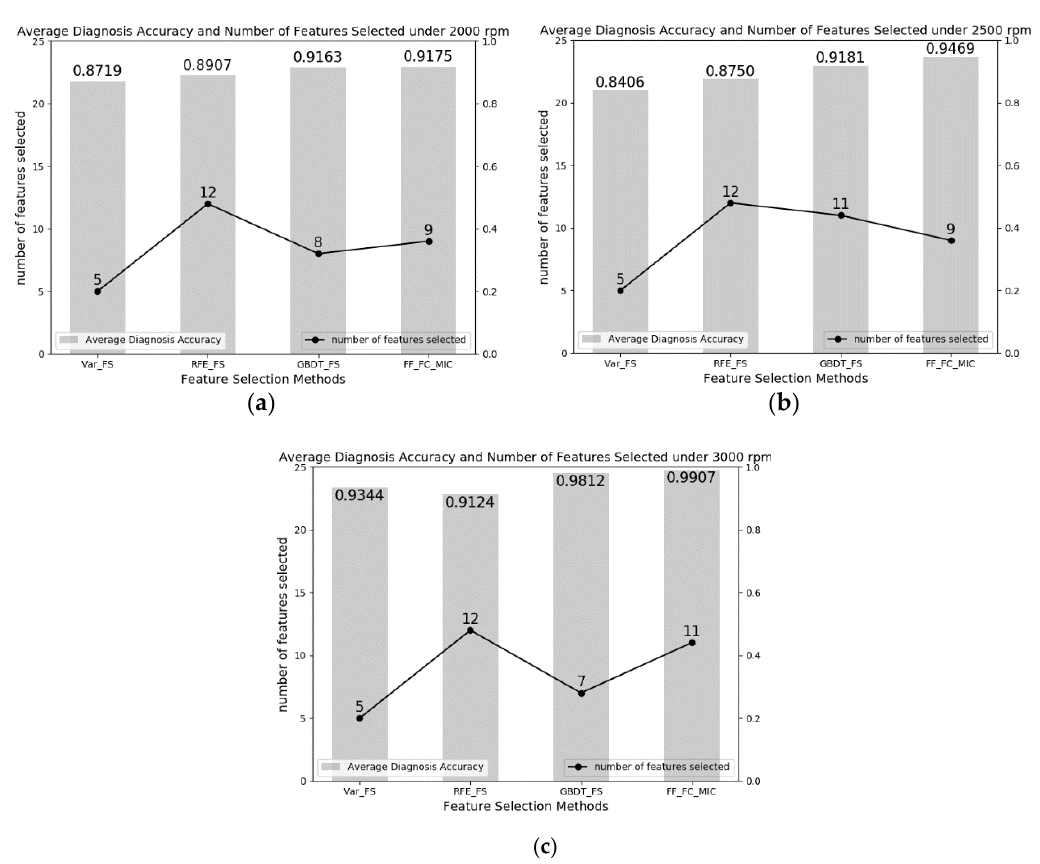
Figure 6. Average diagnosis accuracy of fault and number of features selected at three motor speeds: ( a ) average diagnosis accuracy and number of features selected at the speed of 2000 rpm; ( b ) average diagnosis accuracy and number of features selected at the speed of 2500 rpm; ( c ) average diagnosis accuracy and number of features selected at the speed of 3000